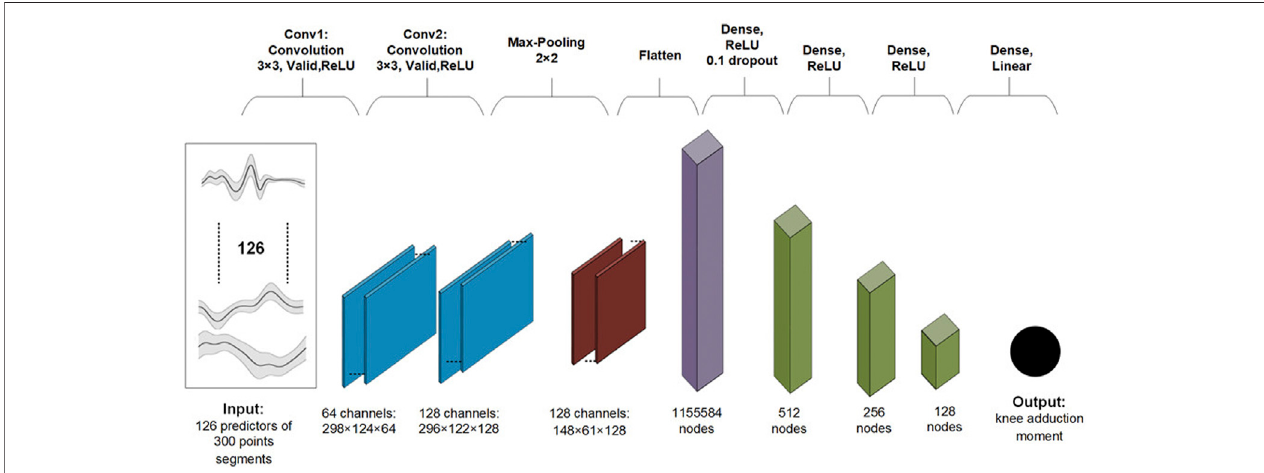
FIGURE 1 | Baseline two dimensional convolutional neural network